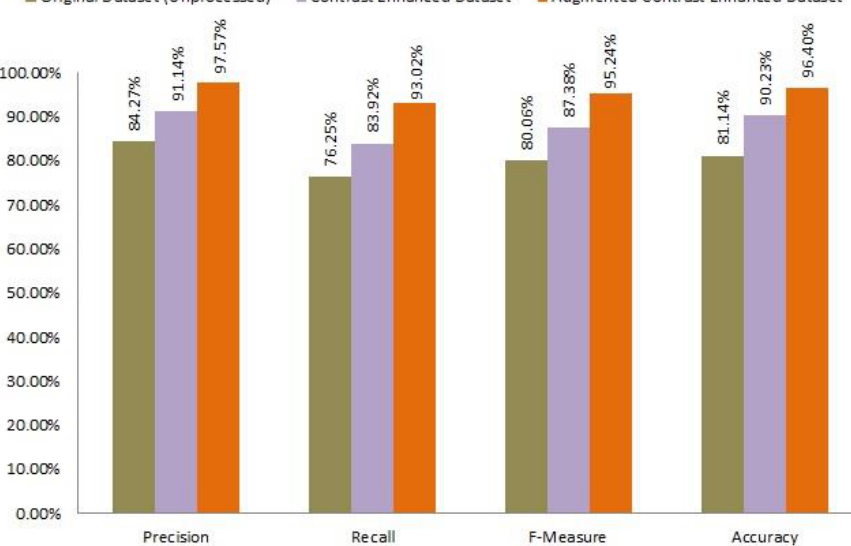
Figure 13. Summarized performance comparison.